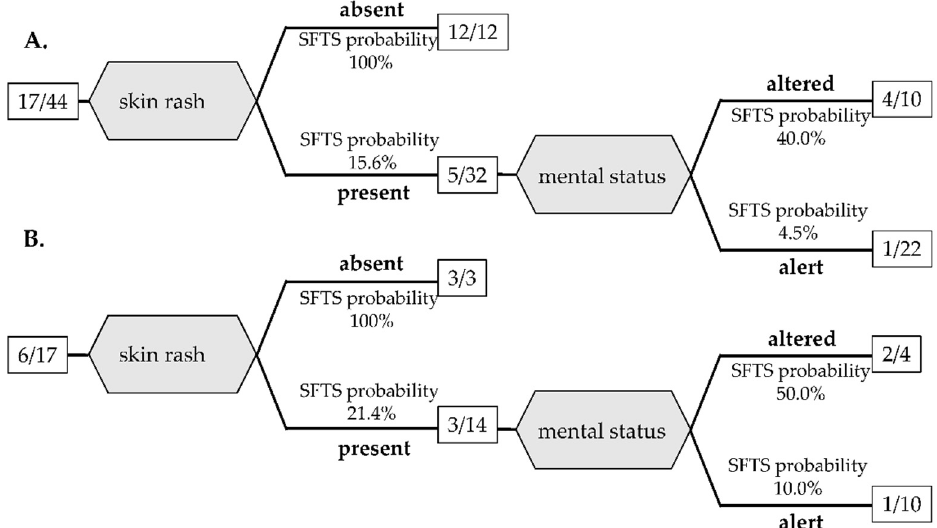
Figure 2. Decision tree classification of SFTS and JSF based on physical examination for the training cohort ( A ) and the validation cohort ( B ). The number in the square is the number of SFTS patients/total patients.